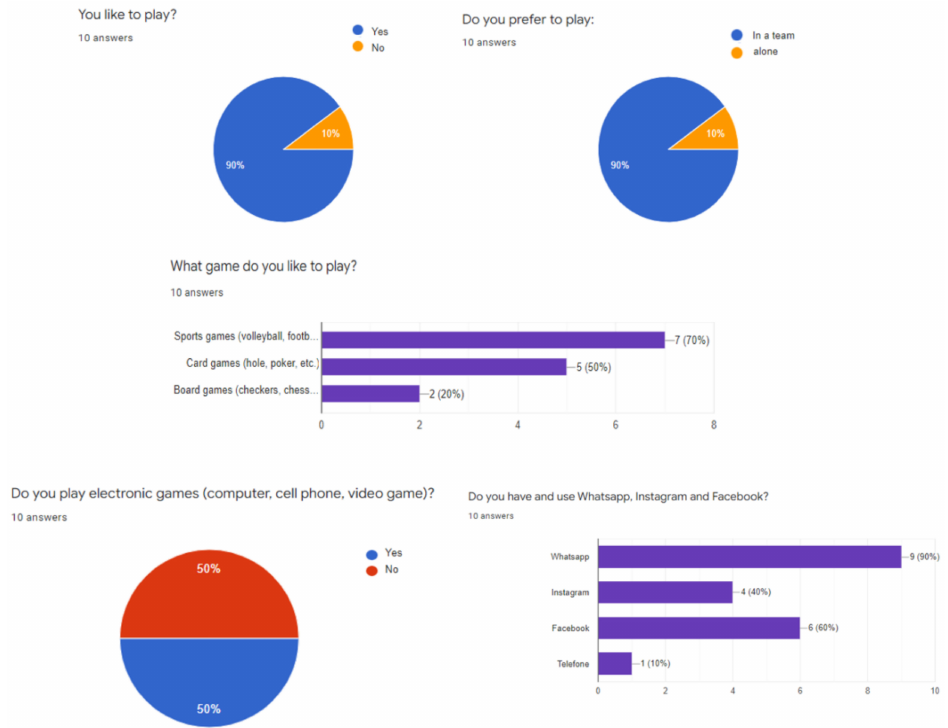
Figure 7. Workers x Games x